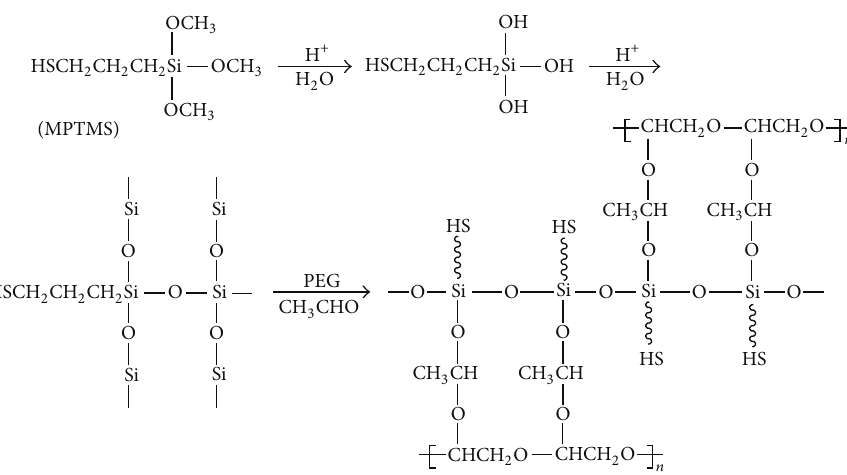
Scheme 1: The possible preparation route of hybrid membranes used in this case